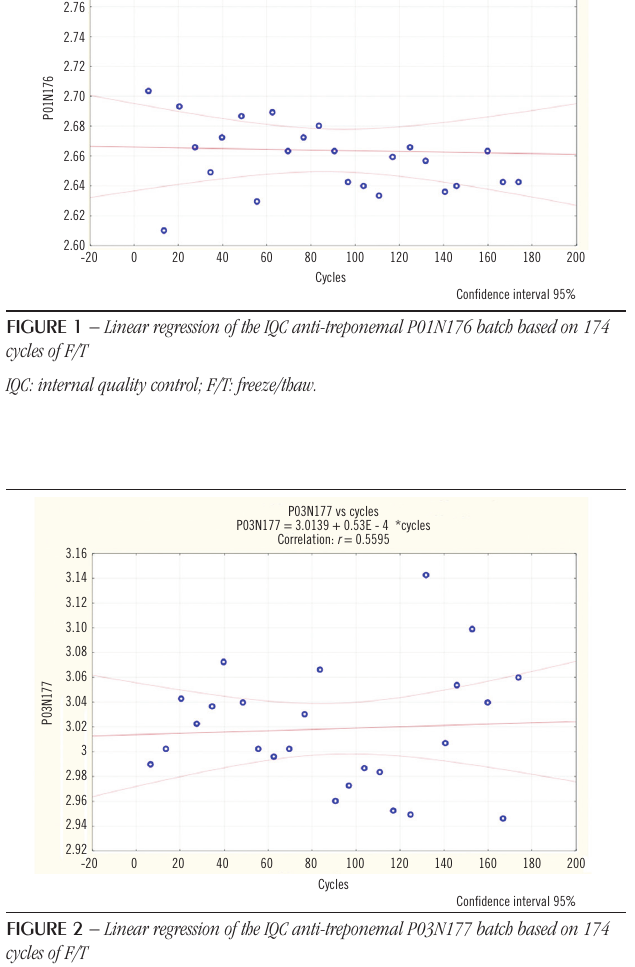
figurE 5 − Linear regression of negative serum (165) batch based on 174 cycles of